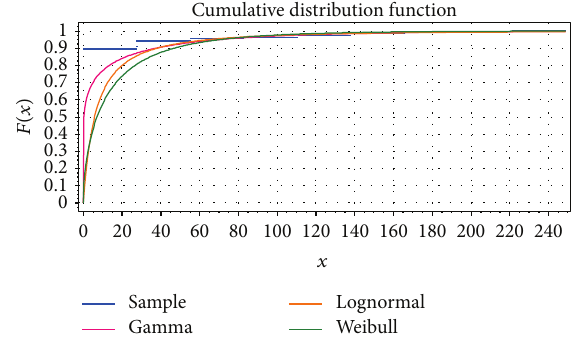
Figure 4: Graph showing the cumulative distribution function of the fitted distributions. Table 4: Estimated number of newly registered industries. Source: